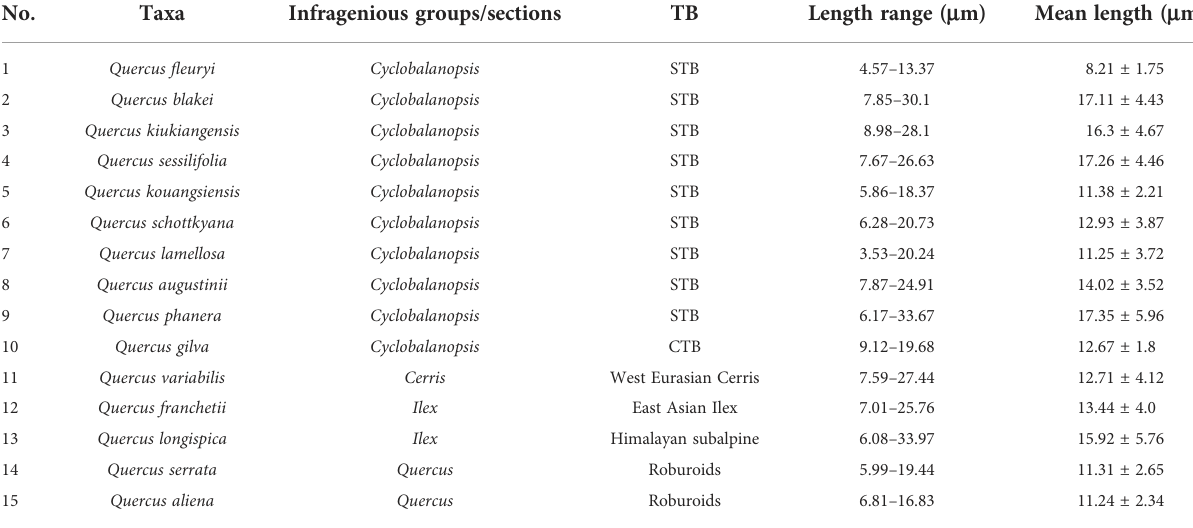
TABLE 2 Plant materials used for morphological analysis based on phylogeny in this study.